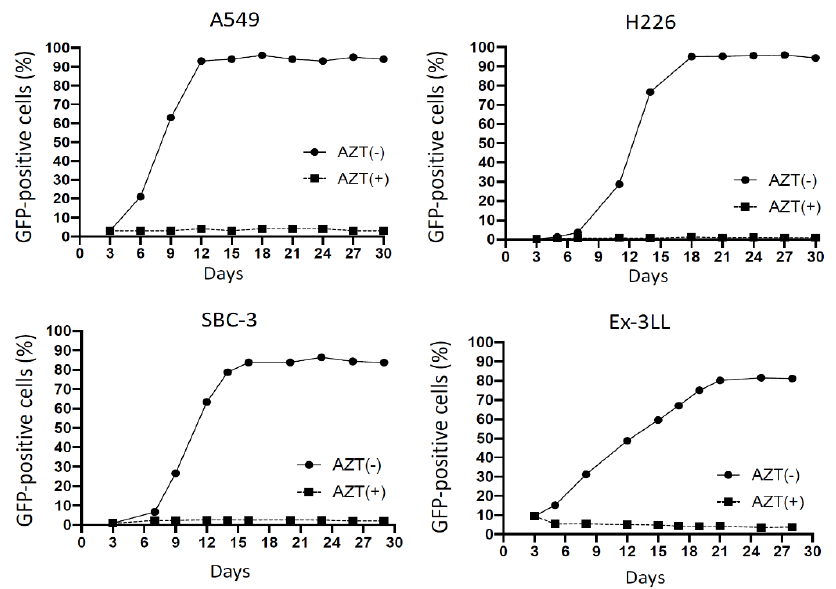
Figure 1. Replication kinetics of RRV-GFP in lung cancer cell lines in vitro. On day 0, all cell lines were transduced with RRV-GFP at MOI 0.01. In negative control cells, reverse transcriptase inhibitor AZT was added on day 3. Cells were evaluated for GFP by flow cytometry every 2–3 days.